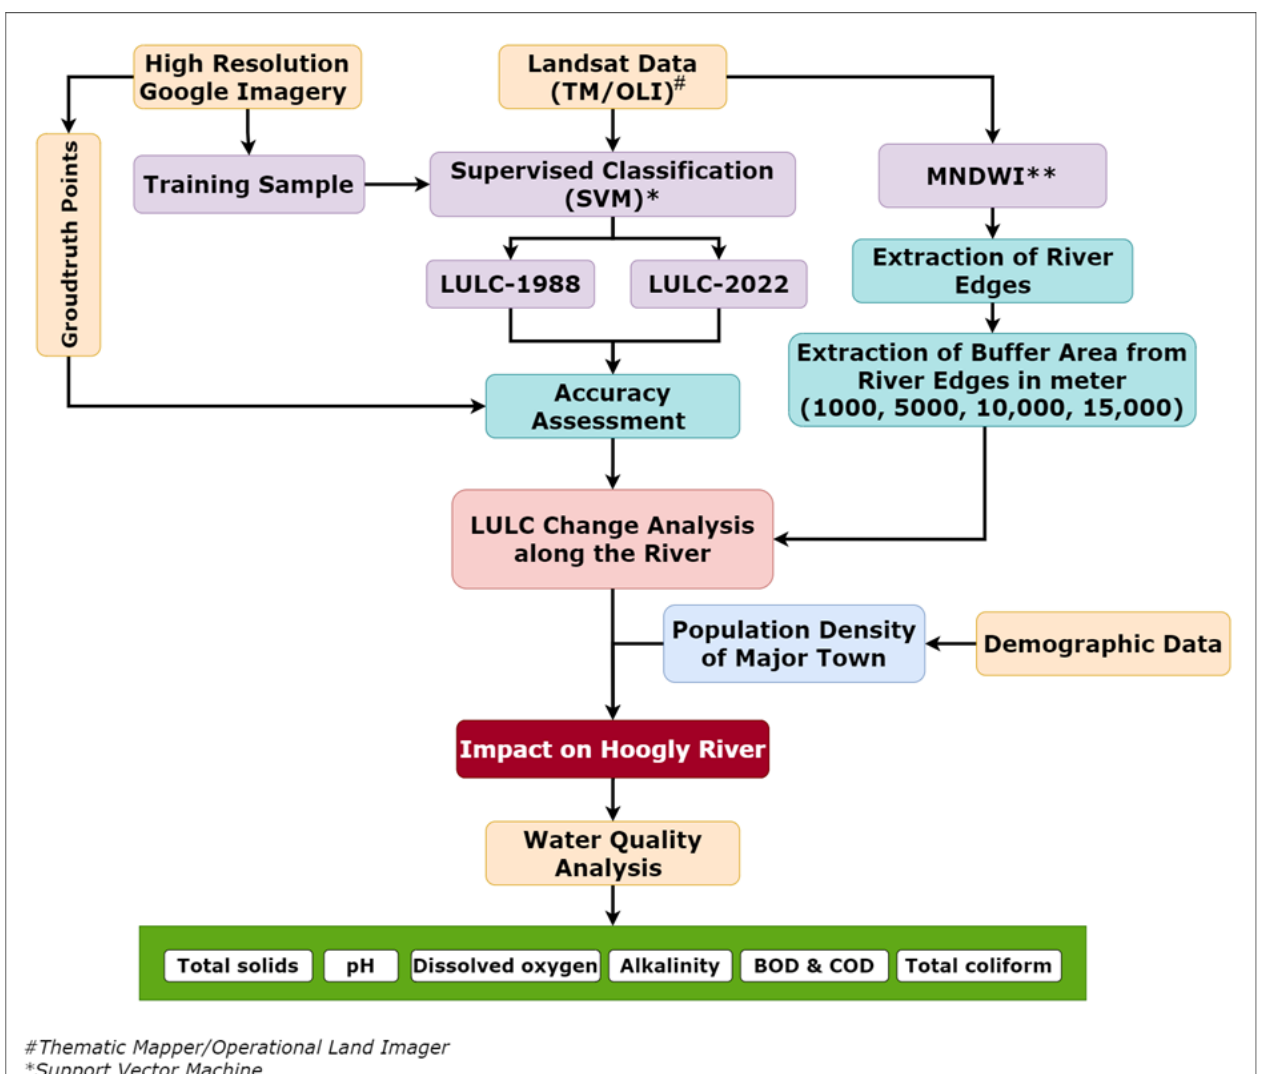
Figure 3. Flowchart of the methodology.